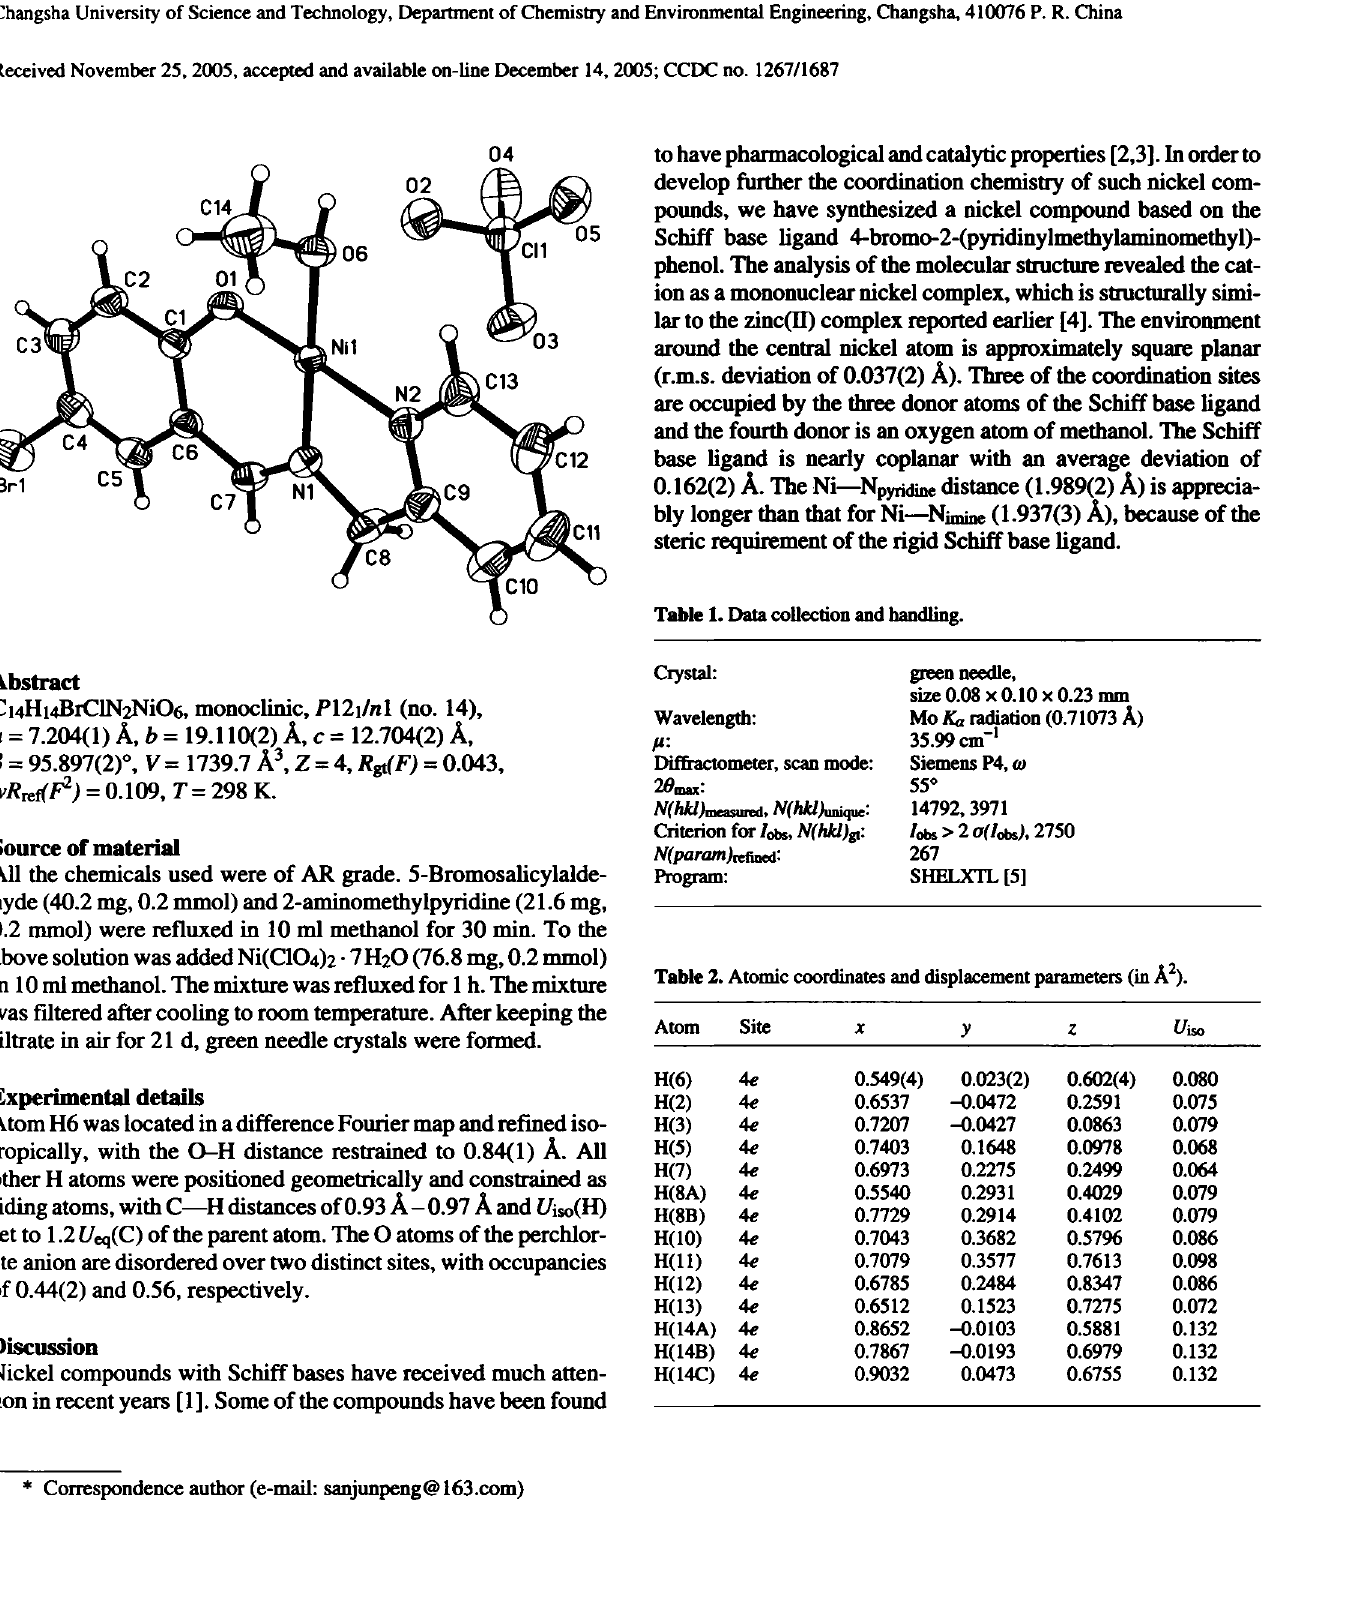
Table 1. Data collection and handling.